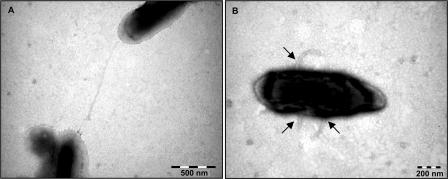
Visualization of R. felis Pili by Transmission Electron MicroscopyBacteria collected from the supernatant of R. felis–infected XTC cells were negatively stained.(A) Sexual pilus observed between two bacteria.(B) R. felis also possesses small appendages likely to be fimbriae pili.